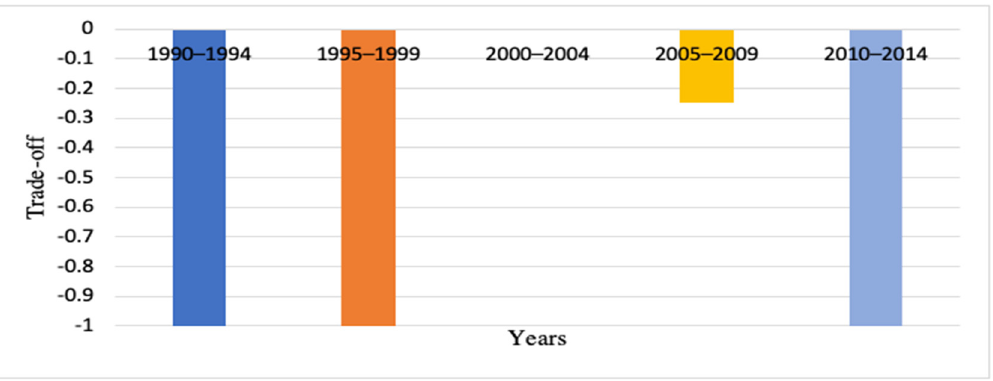
Figure 14. Synergy: GHG emission from transport sector and renewable energy share in total final energy consumption.